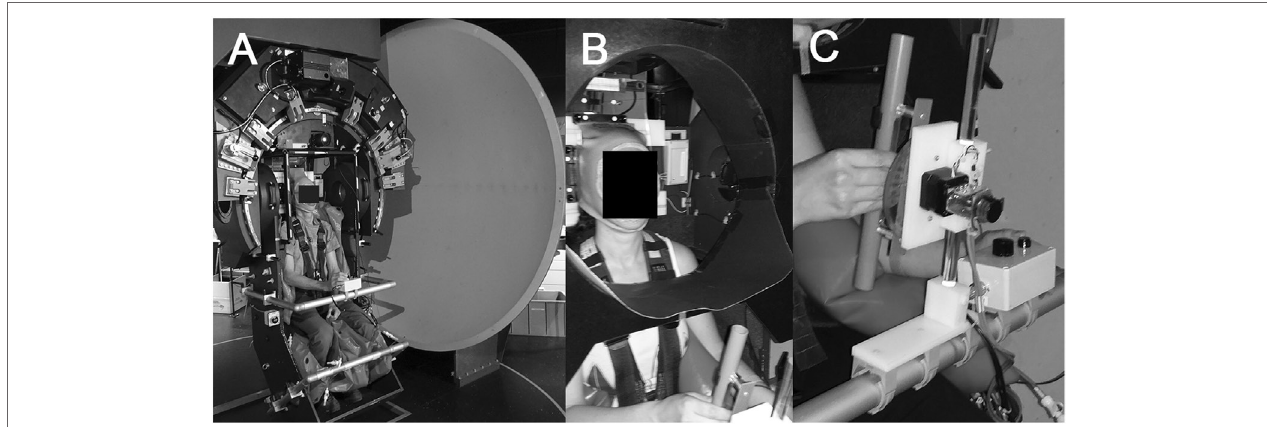
FigUre 1 | Illustration of the experimental setup used. All trials were collected on a three-axis motorized turntable (a) . Details of the thermoplastic mask used to stabilize the subject’s head and to restrict the peripheral visual field downwards (so that the subject could not see the bar during the adjustments) are shown in (B) . Subjects grasped the bar with the right hand and confirmed adjustments by pressing a button placed left of the bar (c)